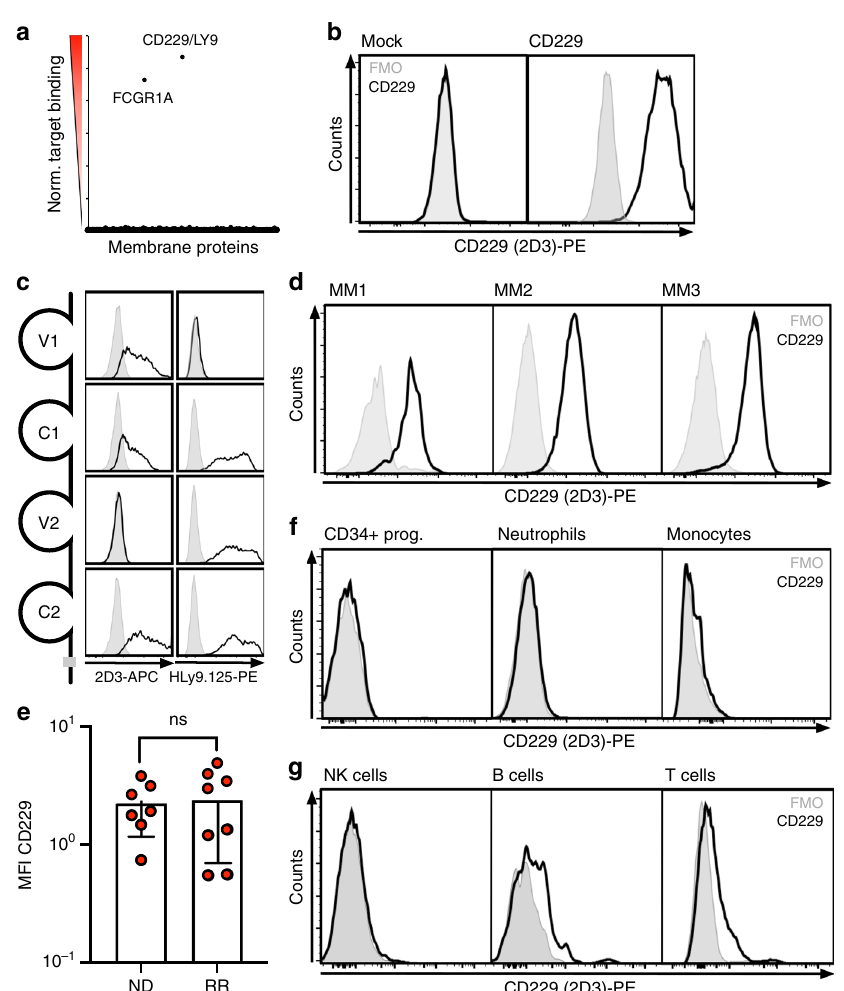
Fig. 2 The fully human anti-CD229 antibody 2D3 binds to MM cells and B and T cells. a Binding of the fully human IgG 1 antibody 2D3 to 293 cells individually expressing 5300 full-length, human membrane proteins as determined by fl ow cytometry. Fc gamma receptor 1A (FCGR1A) serves as a positive control. b K562 cells were stably transduced with a human CD229 expression construct and stained with 2D3. Binding was determined by fl ow cytometry. c Left : The extracellular domain of CD229 consists of two variable and two constant Ig-like domains. In a human CD229 expression construct, each of these domains was replaced with the corresponding mouse homolog as 2D3 did not show any reactivity to mouse CD229 (Supplementary Fig. 2A). Right : Binding by 2D3 and the commercially available CD229-speci fi c antibody HLy9.1.25 33 to the four chimeric proteins expressed on 293T cells was determined by fl ow cytometry. d MM cells were isolated from primary bone marrow samples from three patients with MM using a commercially available MM cell puri fi cation kit (Stemcell Technologies). Puri fi ed MM cells were stained with 2D3 and binding was determined by fl ow cytometry. e Bone marrow samples from seven patients with newly diagnosed (ND) and eight patients with relapsed/refractory (RR) MM were stained with 2D3 and analyzed by fl ow cytometry. Data represent mean ± standard deviation and statistical signi fi cance was determined by two-sided Student ’ s t- test. f CD34 + hematopoietic progenitors, neutrophils, monocytes, g natural killer (NK) cells, B cells, and T cells were isolated from peripheral blood from a healthy donor using commercially available puri fi cation kits (Stemcell Technologies). Cells were stained with 2D3 and analyzed by fl ow cytometry. Source data are provided as a Source Data fi